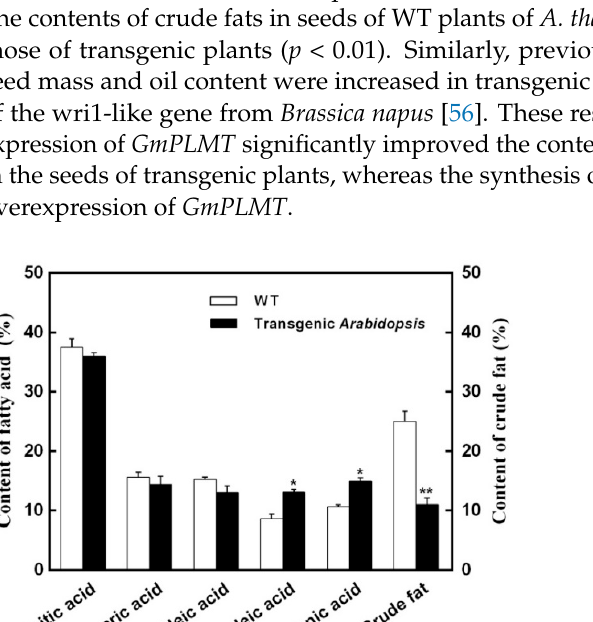
Figure 12. Contents of total phospholipids, phosphatidylcholine (PtdCho), and phosphatidylethan- olamine (PtdEtn) in seeds of wild type (WT) and transgenic plants of Arabidopsis thaliana with GmPLMT . Symbols “*” and “**” indicate significant differences at p values of 0.05 and 0.01, respec- tively.